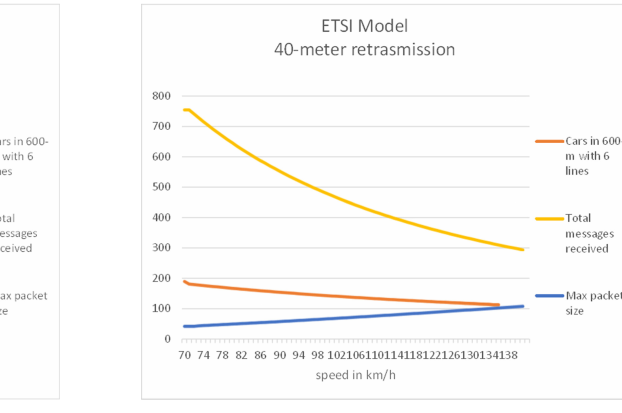
Figure 5. ( a ) European Telecommunications Standards Institute (ETSI) model; ( b ) details of the ETSI